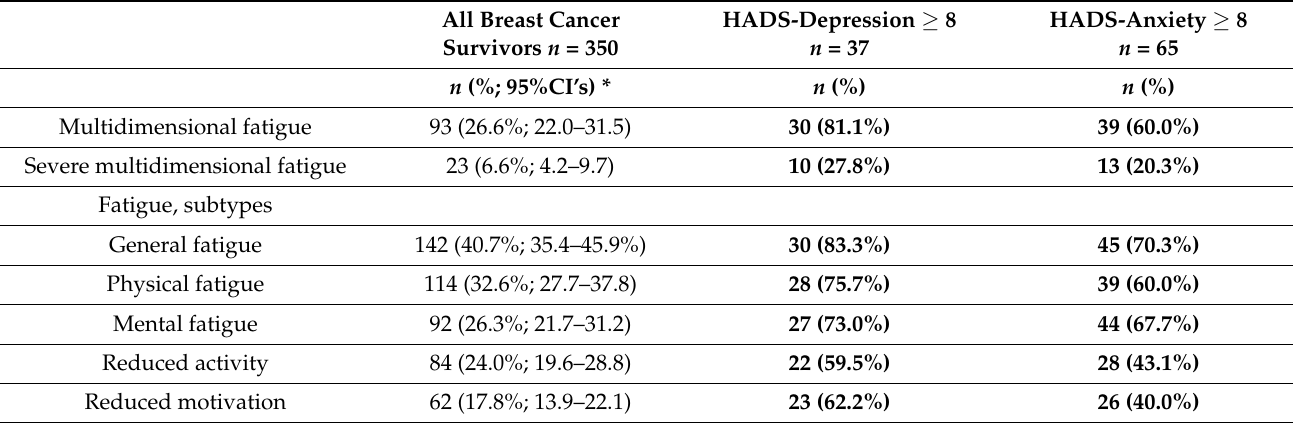
Table 4. Fatigue among breast cancer survivors ( n = 350) overall and stratified for women with symptoms of depression ( n = 37) or anxiety ( n =